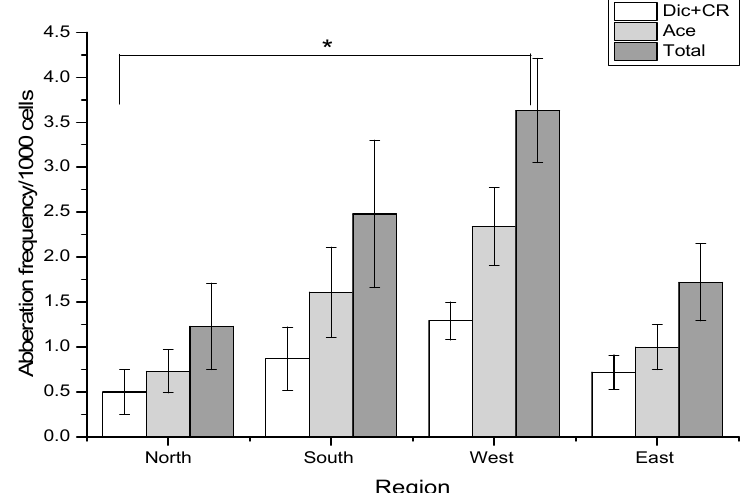
Figure 1. Chromosome aberration frequencies in different regions of Kazakhstan. The asterisk indicates a significant difference ( p < 0.05) between Dic + CR, Ace and total chromosome aberrations between the northern and western groups.